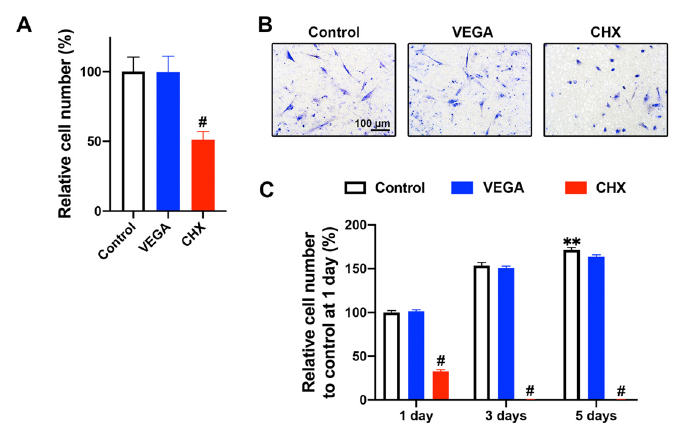
Figure 3. The effects of antiseptic oral rinses on HGF-1 ( A , B ) cell migration and ( C ) proliferation. ( A ) The migrated cell numbers (n = 9) and ( B ) images of the migrated cells at 24 hours after either 1% VEGA or CHX treatment. ( C ) Proliferation assay of HGF-1 cells exposed to either 1% of VEGA or CHX at 1, 3, and 5 days (n = 5). It was found that 1% VEGA treatment showed similar cell migration and proliferation properties to control, whereas 1% CHX treatment inhibited cell migration and proliferation (** denotes significantly higher than all other treatment modalities. * denotes significant difference between groups. # denotes significantly lower than other modalities, p < 0.05).